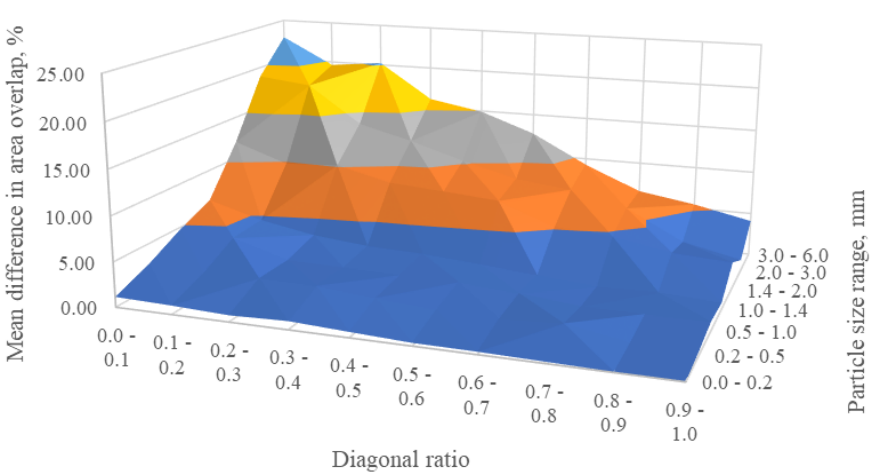
Figure 7. Average discrepancy of area limited by the pellet’s silhouette when pellets are evaluated